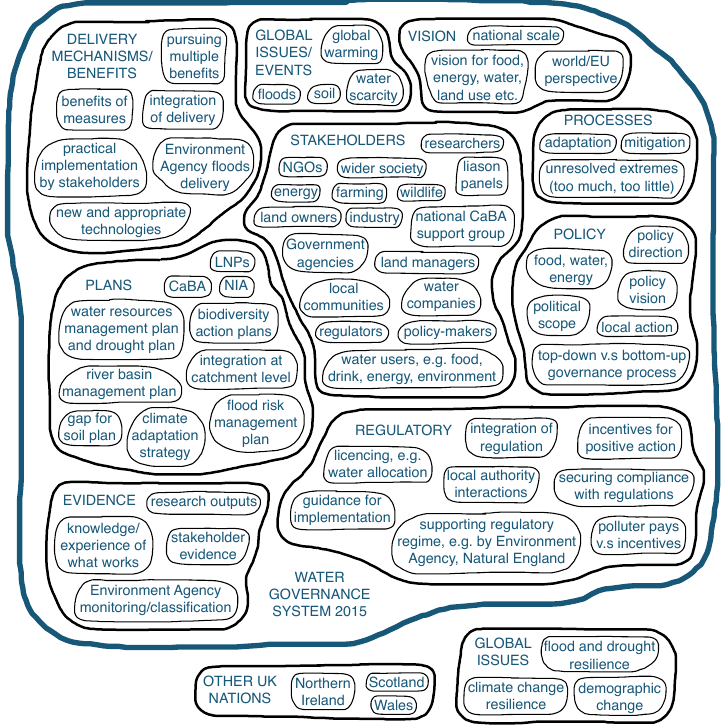
Figure 2. A systems map of the current water governance system in England constructed by a group of workshop participants (redrawn from the version created at the workshop; see also Figure S2) [29]. The systems maps enabled the identification of the actors and elements in the water governance situation that the participants perceived to be